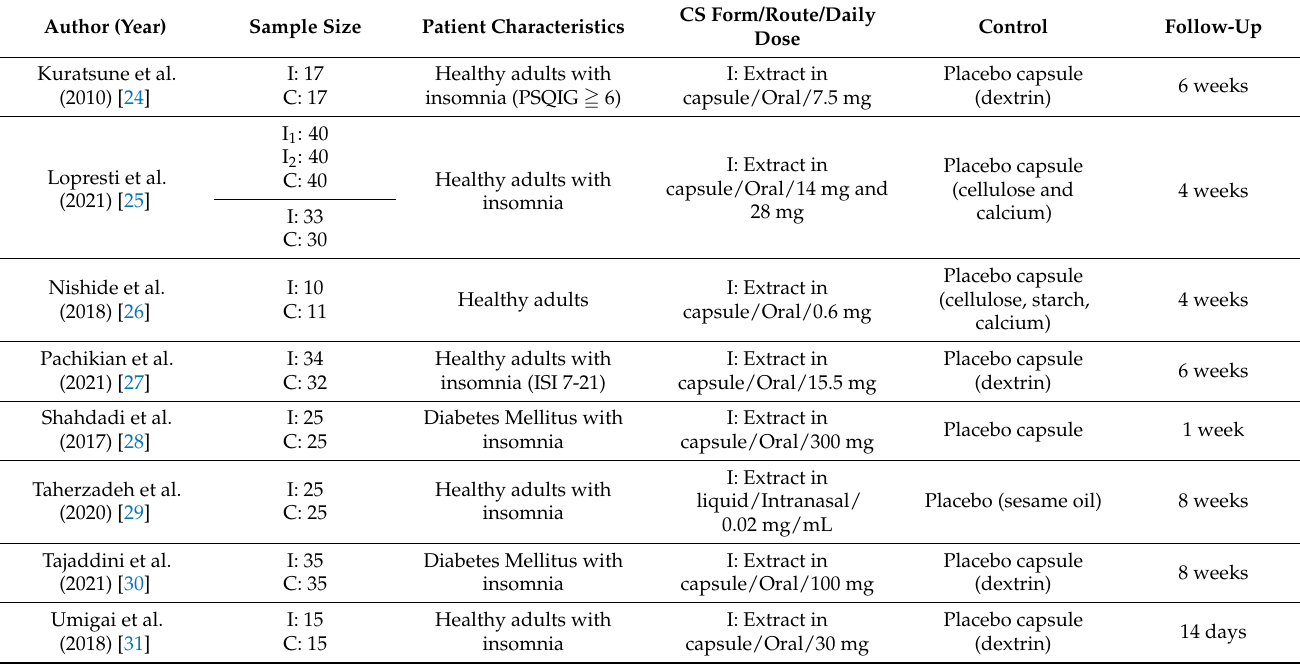
Table 1. Characteristics of included